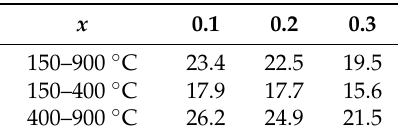
Table 4. Thermal expansion coefficients (TECs) (ppm · K − 1 ) of Sr 3 − x Pr x (Fe 1.25 Ni 0.75 )O 7 − δ , x = 0.1, 0.2, and